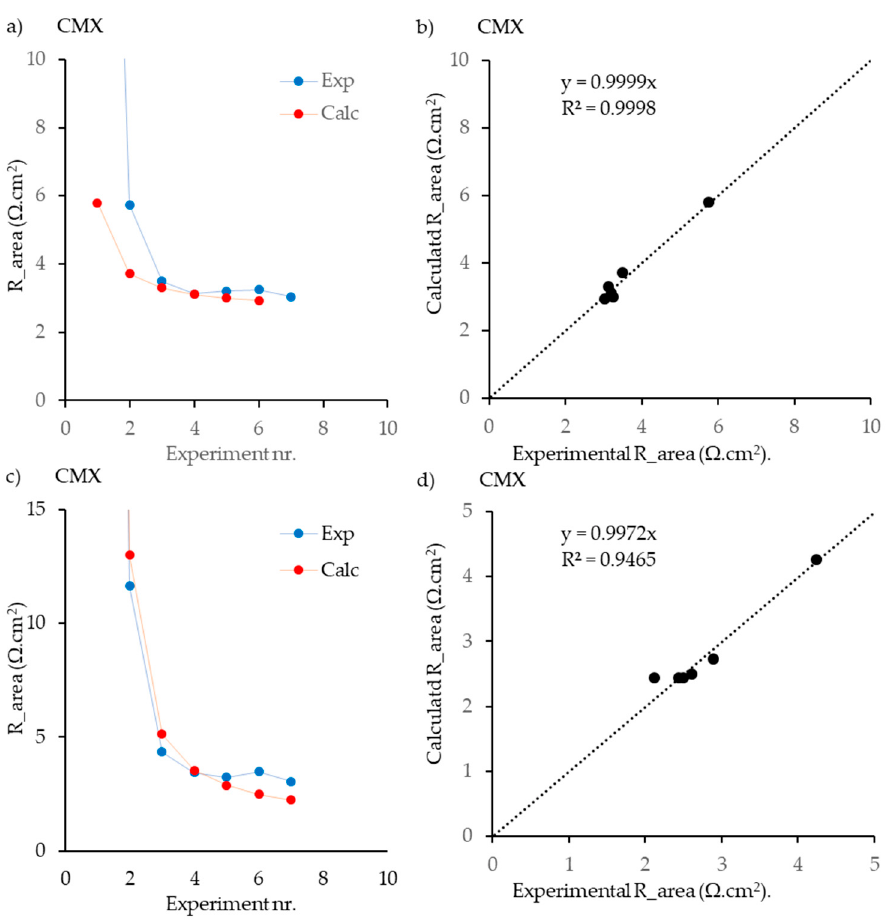
Figure 5. Results of the fitting procedure for the CMX membrane in pure NaCl solutions. ( a , b ) Derived from AC measured resistances and ( c , d ) from DC measurements from Galama et al. [33]. In ( a , c ), lines are added to guide the eye; in ( b,d ) the regression lines are shown.